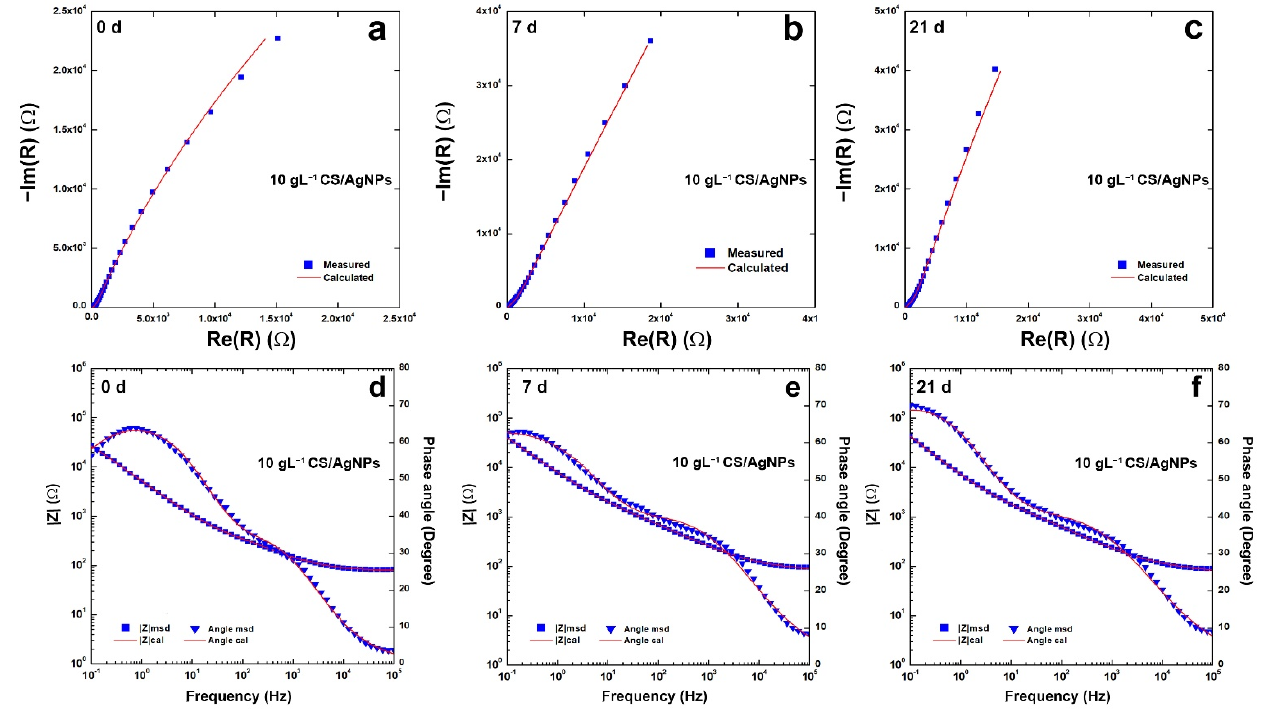
Figure 7. ( a – c ) Nyquist and ( d – f ) Bode plots of the composite coatings obtained using 10 gL − 1 of CS after different aging time.